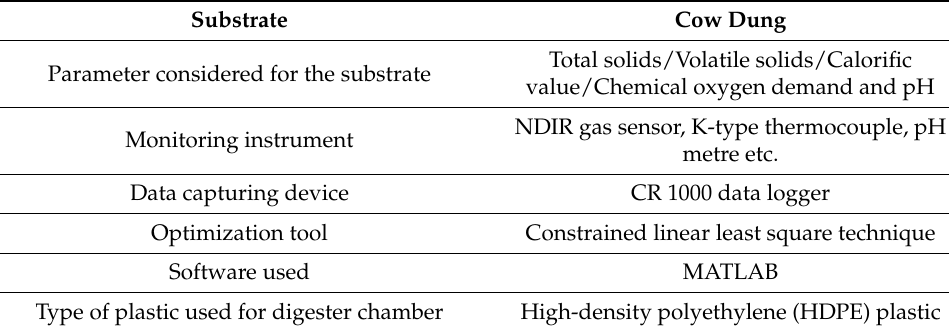
Table 3. Summary of the material and equipment used in the